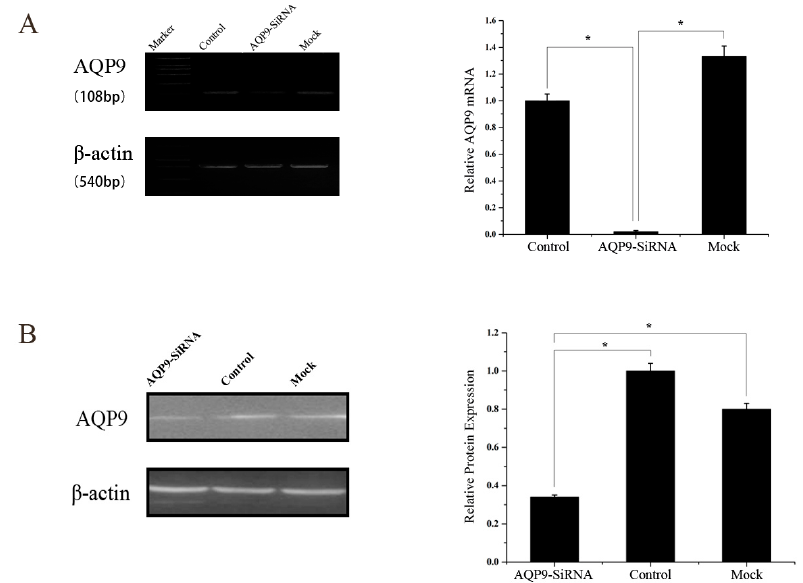
Figure 3. Expression of AQP9 in PC3 cells, AQP9-siRNA and Mock were analyzed by real-time-PCR ( A ) and Western blot ( B ) ( p < 0.05 as compared with control). △ CT AQP9/ β -actin (control PC3) was 6.348. Control: wild-type cells; AQP9-siRNA: cells transfected with AQP9 specific small interfering RNA; Mock: cells only treated with Lipofectamine 2000. The mean of AQP9/ β -actin expression in PC-3 cells compared with